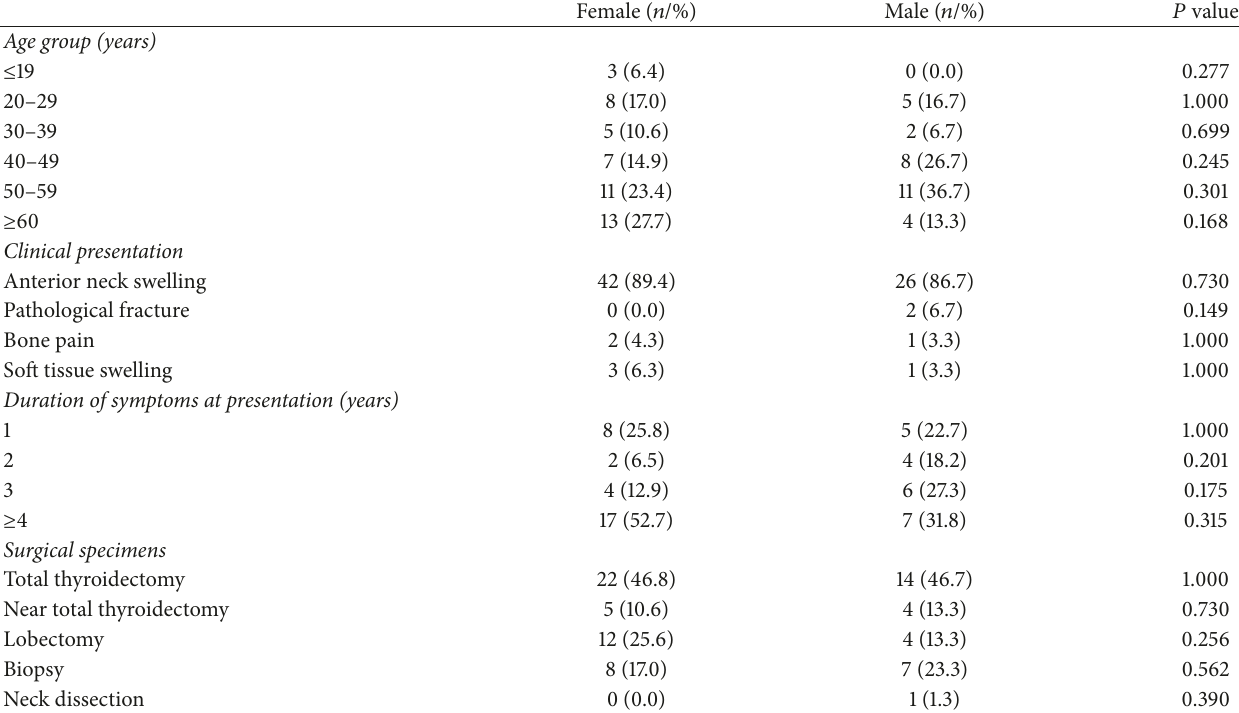
Table 1: Demographic characteristics and the clinical presentation of FCTs in females and